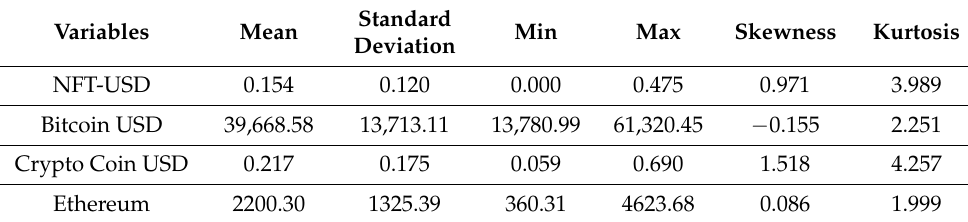
Table 2. Summary Statistics of Dependent and Explanatory Variables.